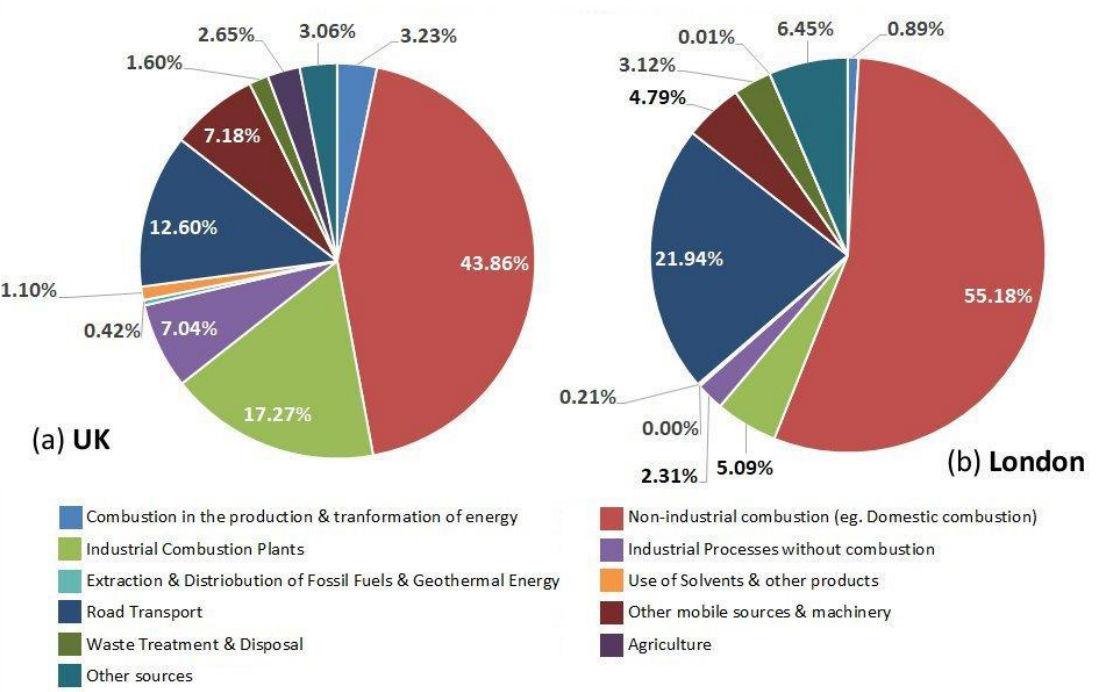
Figure 2. A sectoral breakdown of PM 2.5 emissions in 2018, contrasting to the contribution of emis- sions from different sectors nationally ( a ) with the domination of domestic combustion and road transport emissions in London ( b